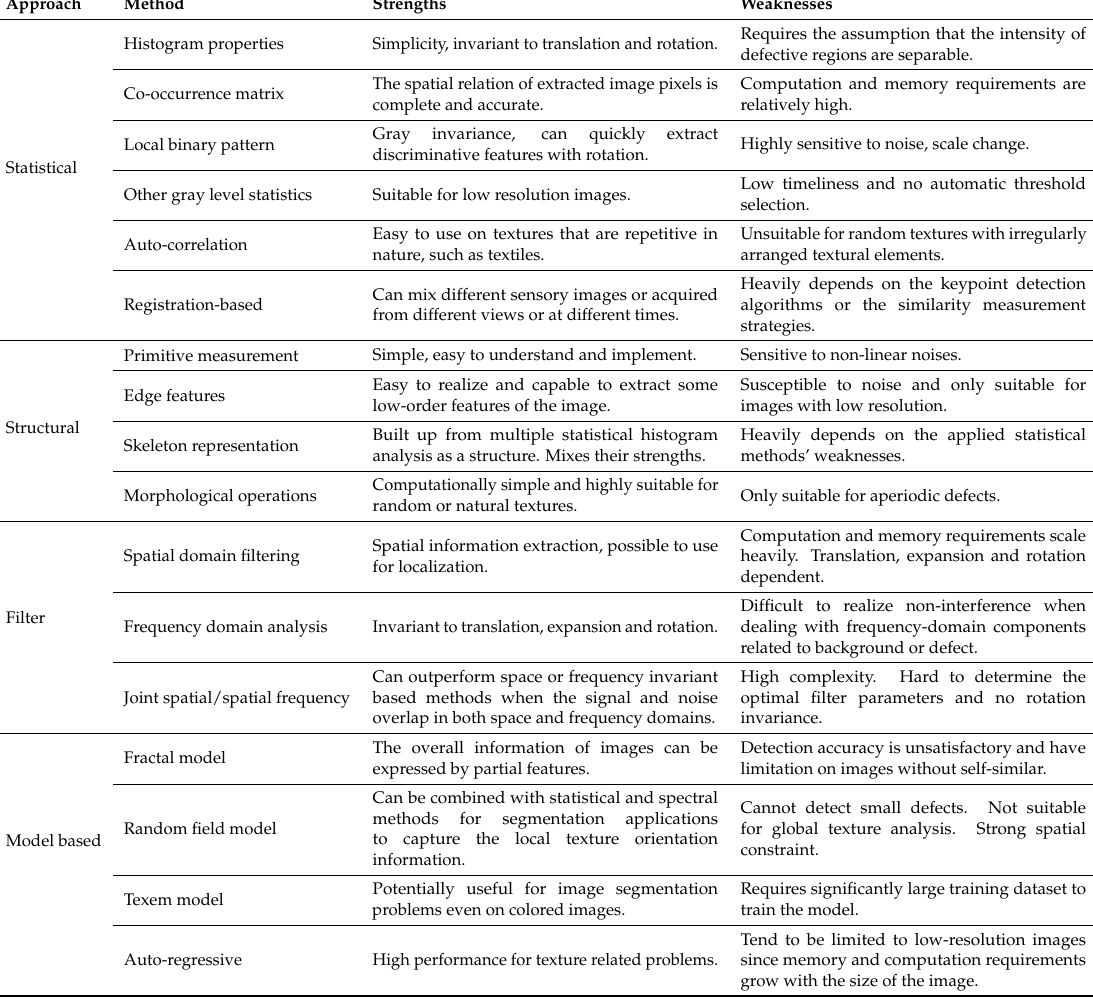
Table 1. Strengths and weaknesses of different image processing